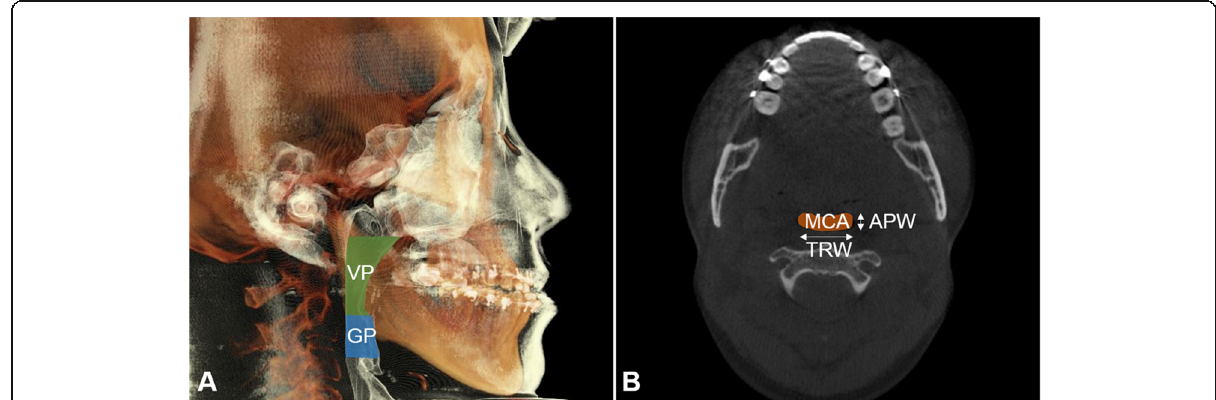
Fig. 3 Oropharyngeal airway space measurements. a Segmentation of velopharynx (VP) and glossopharynx (GP) volume (mm 3 ). b Minimal cross- sectional area (MCA) (mm 2 ), anteroposterior width (APW) of MCA (mm), and transverse width (TRW) of MCA (mm)